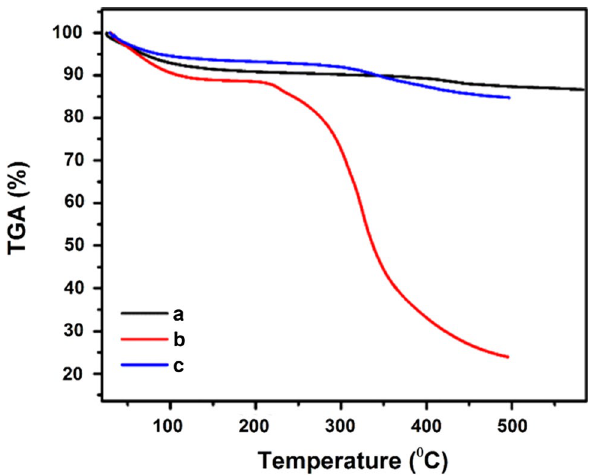
Fig. 4 Thermogravimetric analyses of DC ( a ), BSA ( b ) and BSA adsorbed DC ( c ) after 120 min